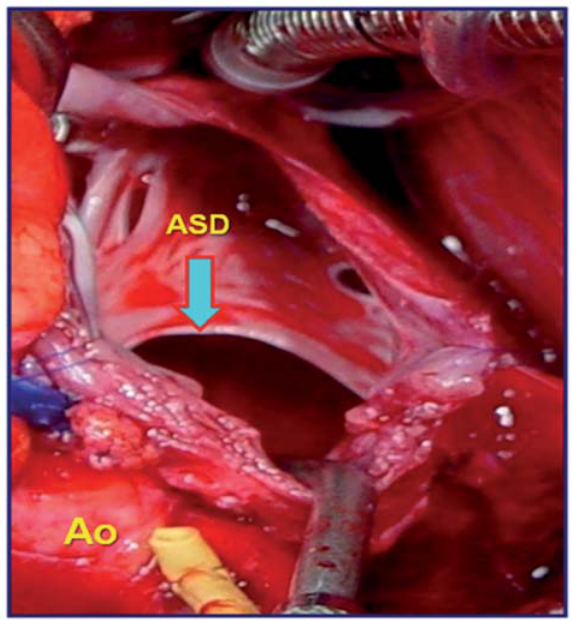
Fig. 3 - Surgical image shows: patient on cardiopulmonary bypass, after atrial approach we observed a large atrial septal defect (ASD). Ao =